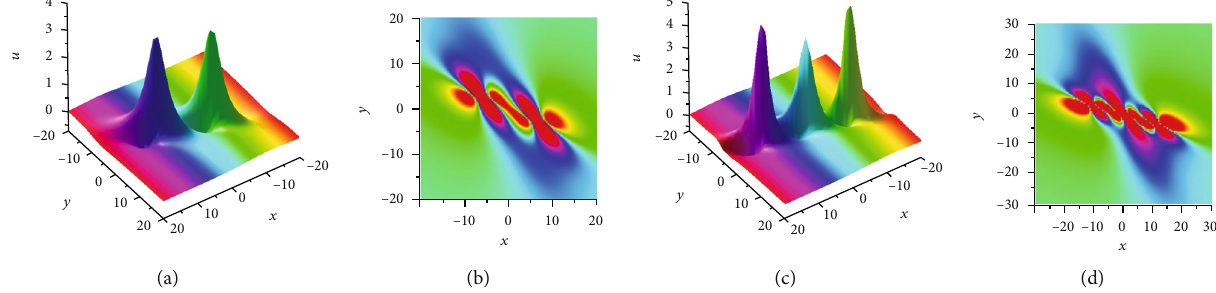
= 1 + I , p = 1 − I , p = 1/2 + ð 1/2 Þ I , p 1 3 2 = 3/2 − ð 3/2 Þ I . 6